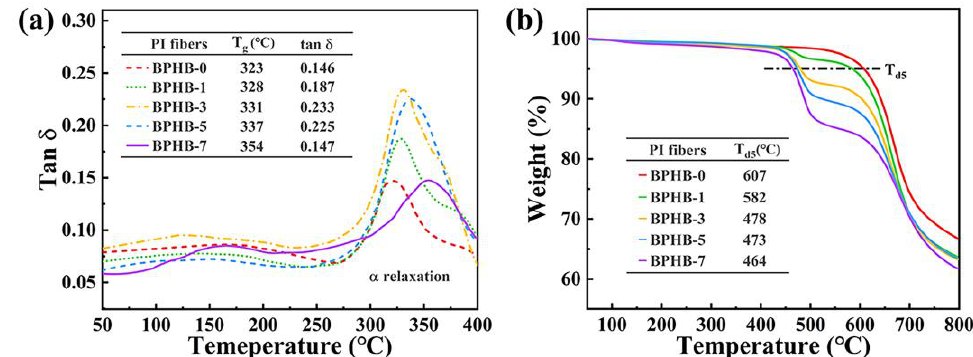
Figure 5. ( a ) DMA curves and ( b ) TGA curves of the PI fibers with different p – PDA /HAB/BIA molar ratios.